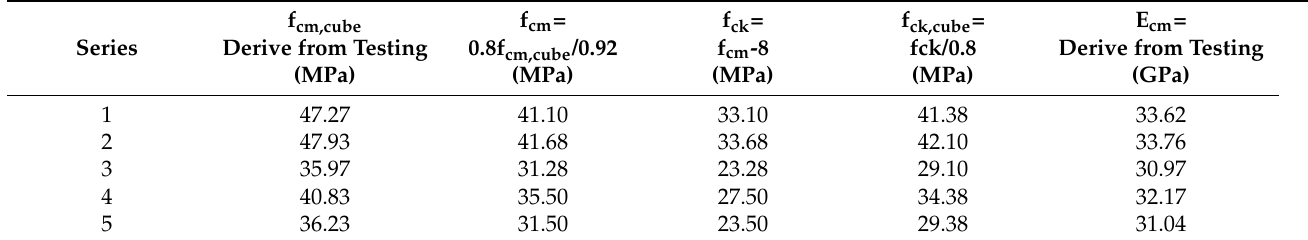
Table 2. Performance of concrete.